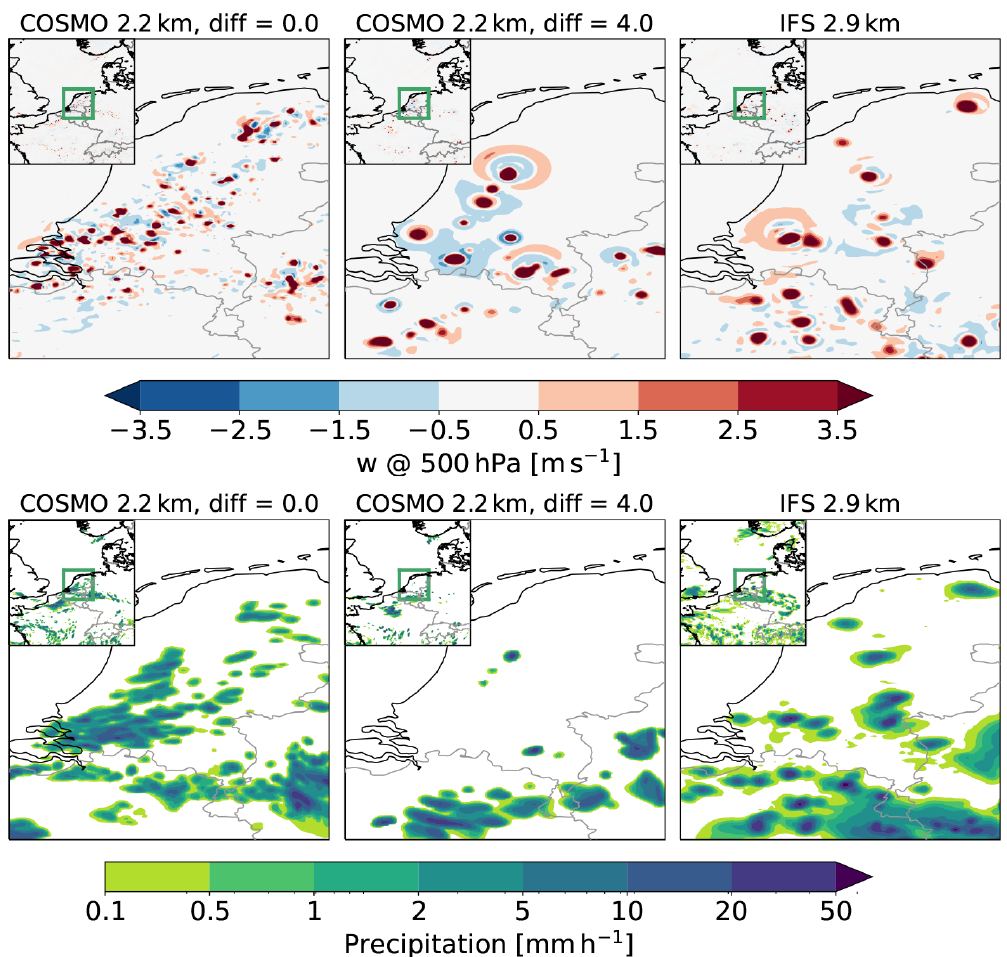
Figure 10. Vertical wind at 500hPa (upper row) and accumulated hourly precipitation (lower row) over the Netherlands on 29 May 2018 at 14:00UTC. The first column shows the values from COSMO 2.2km without explicit horizontal diffusion, while the middle column shows the results from a simulation with additional diffusion. The right column shows to the values obtained from the IFS2.9km simulation with (cid:49)t = 120s.